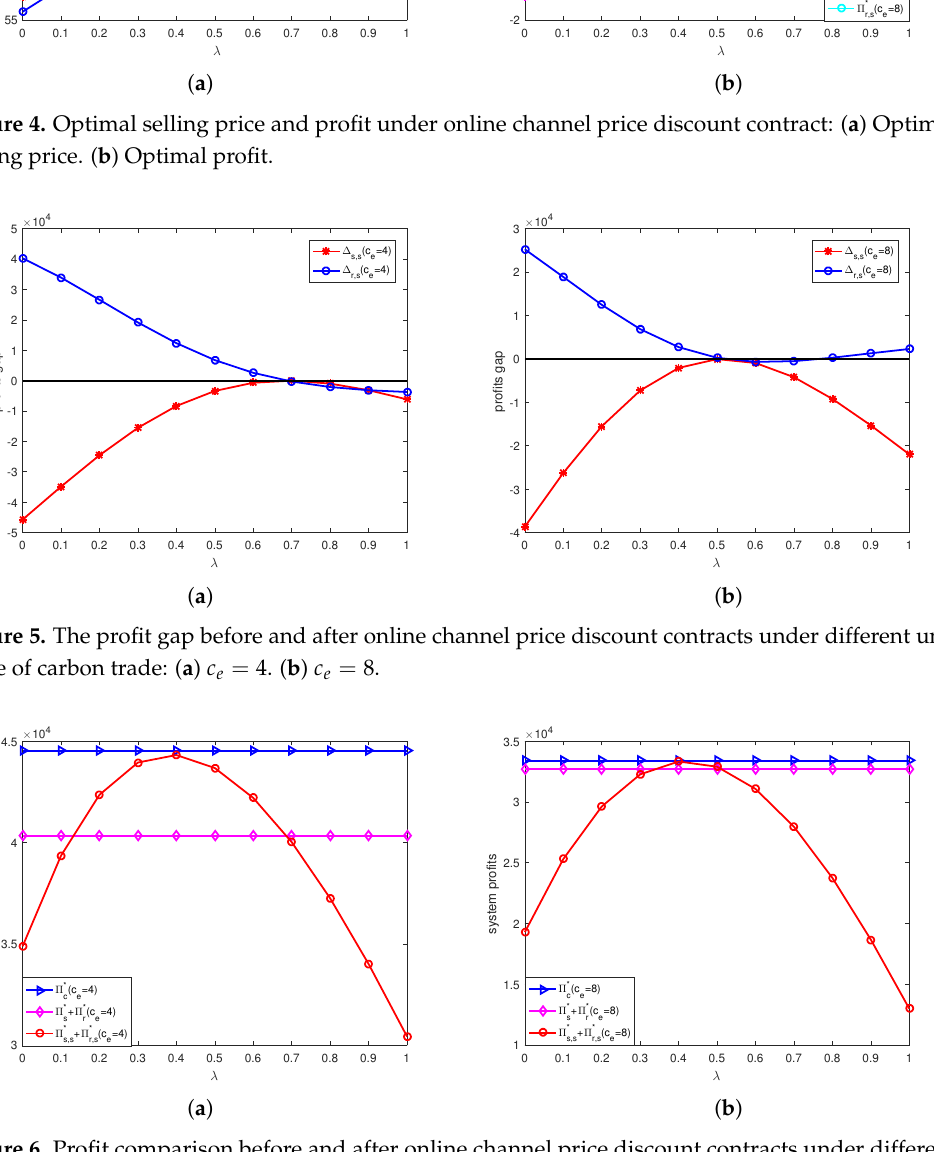
Figure 6. Profit comparison before and after online channel price discount contracts under different unit price of carbon trade: ( a ) c e = 4. ( b ) c e =